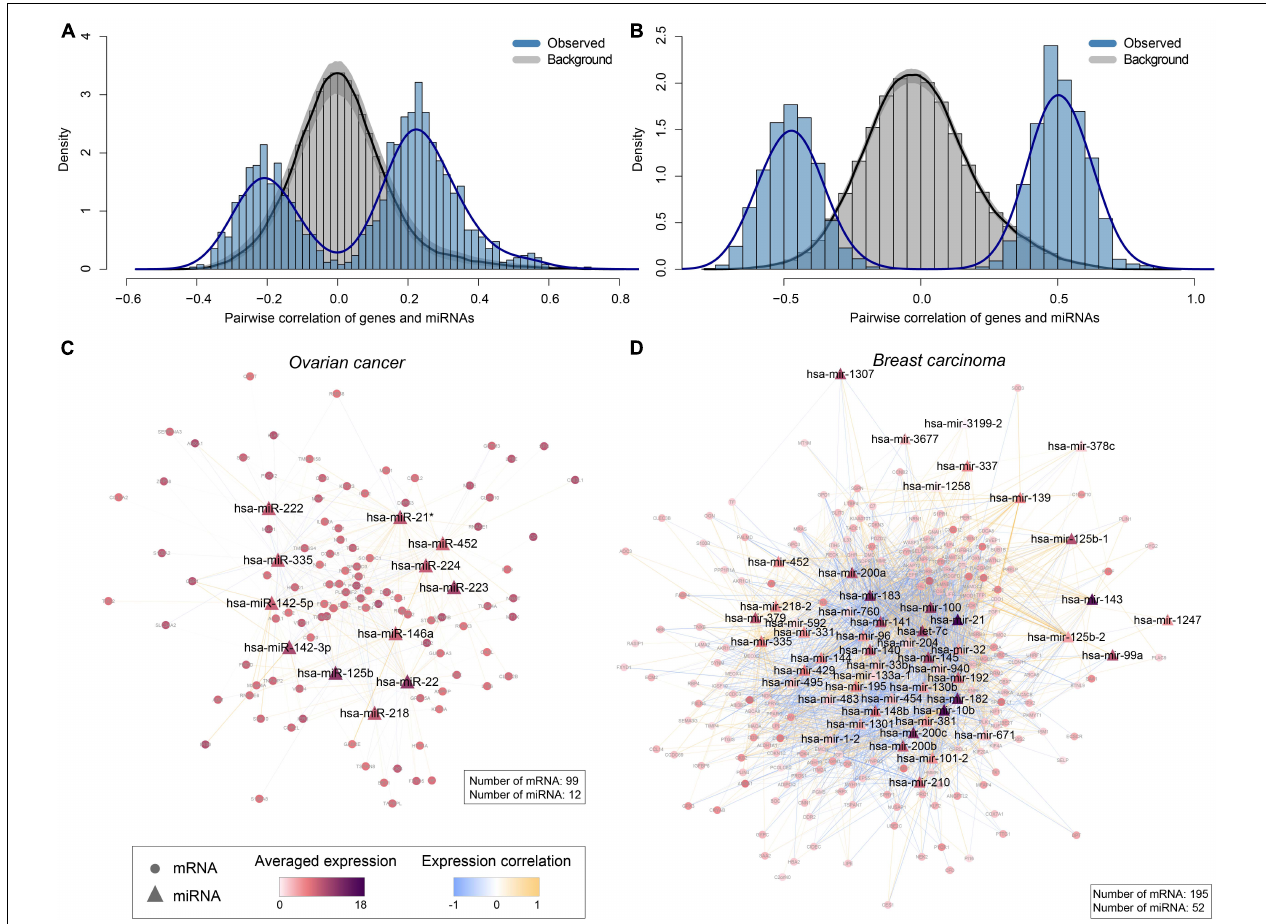
FIGURE 5 | Interpretations of the canonical variate pairs. (A,B) The distributions of observed pairwise correlation coefficients between non-zero mRNA variables and miRNA variables in the first canonical variates, compared to the corresponding background distributions in this panel (A) ovarian cancer and (B) breast carcinoma (BRCA), respectively. The gray area represents 95% confidence intervals. (C,D) MiRNA-mRNA regulatory networks constructed based on non-zero mRNA and miRNA variables selected by sparse CCA in this panel (C) ovarian cancer and (D) breast carcinoma, respectively. Triangles and circles represent miRNAs and mRNAs, respectively. Edges represent the interactions between miRNAs and mRNAs experimentally validated and/or predicted by databases including miRecords, miRTarBase, TarBase, TargetScan, PITA, and miRanda. Nodes are colored in proportion to the averaged log2 transformed expression levels of mRNAs/miRNAs across all TCGA samples, and edges are colored based on Pearson correlation coefficients between the expression levels of miRNAs and